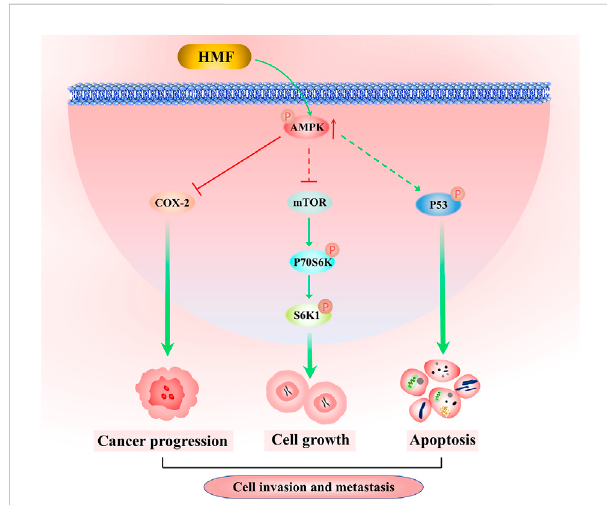
FIGURE 7 Molecular mechanism by which HFM inhibits nasopharyngeal carcinoma cell growth. HMF-induced AMPK activation inhibits NPC cell growth, invasion, and metastatic potency via downregulation of theactivationofthemTORsignalingpathwayandCOX-2protein levels, as well as enhancement of p53